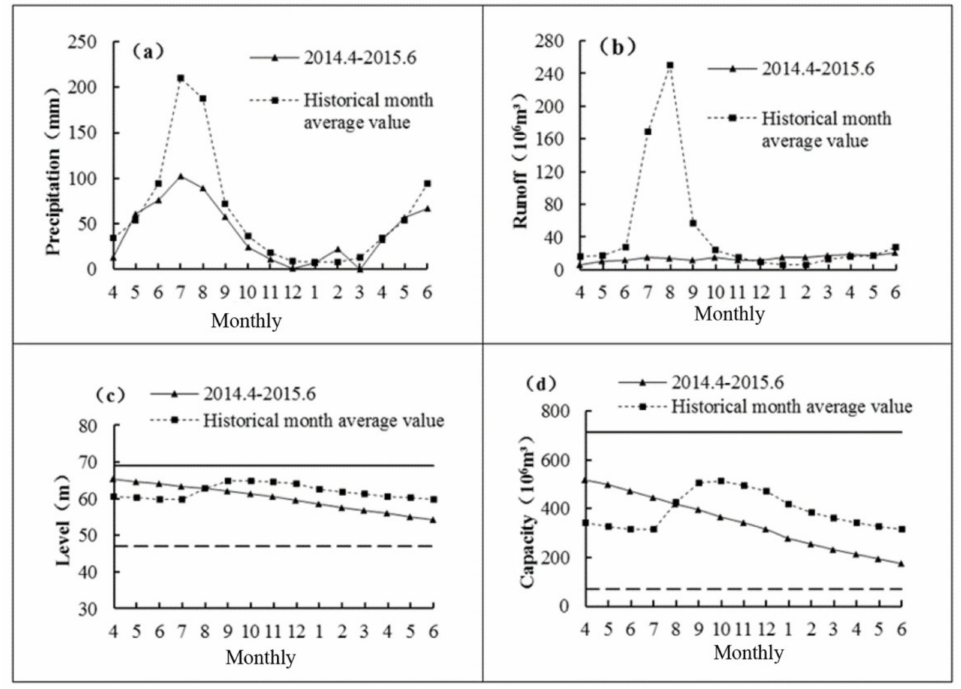
Figure 4. The monthly change of precipitation ( a ), runo ff ( b ), water level ( c ), and capacity ( d ) of Biliuhe